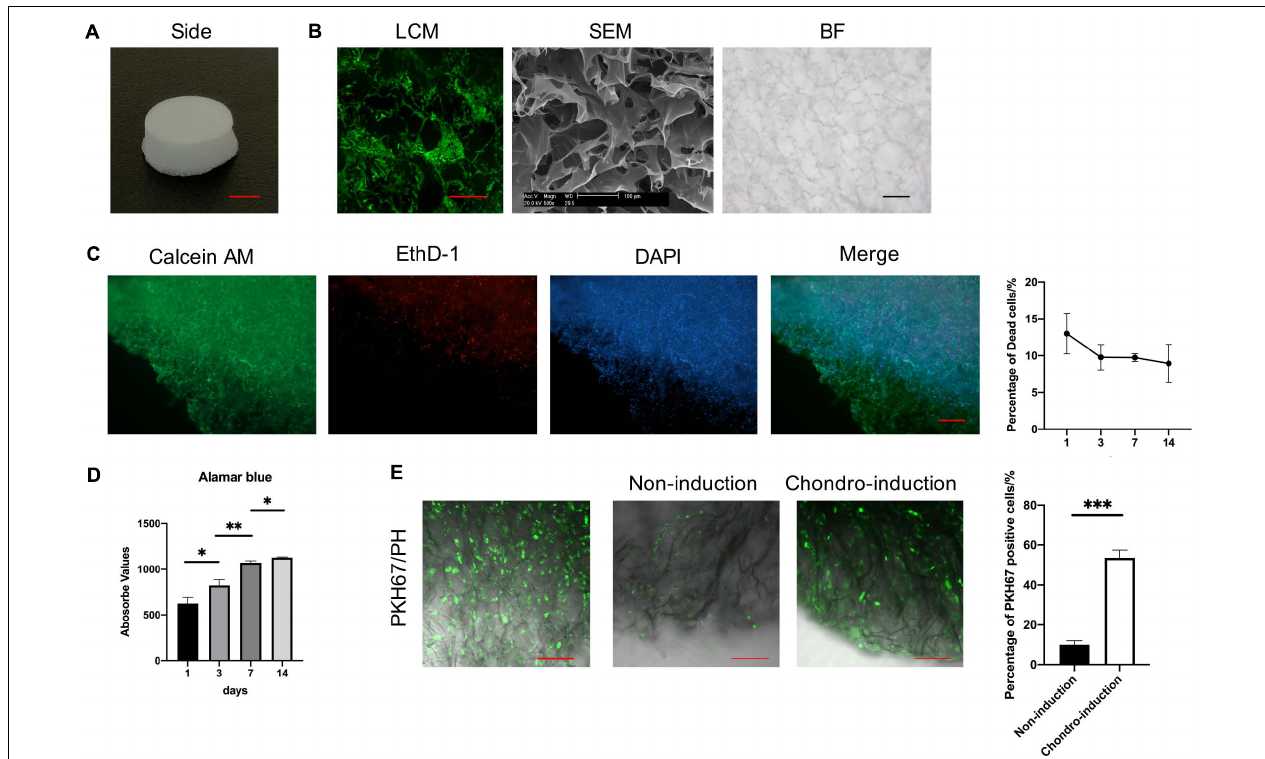
FIGURE 2 | The characterisation of CII-sponges. (A) The appearance of CII-sponges, scale bar 0.5 cm. (B) The pore structure of CII-sponges scanned by laser confocal (LCM), scanning electricity (SEM), and bright field (BF) Microscopes, scale bar 200 µ m (LCM), 100 µ m (SEM), and 200 µ m (BF). (C) The cell viability of TSPCs seeded in CII-sponges was detected by LIVE/DEAD assay, live cells (Green), dead cells (Red), and Nuclei (Blue), scale bar 200 µ m. The percentage of dead cells in total cells at day 1, 3, 7, and 14 were analysed by Image ProPlus. (D) AlamarBlue detected the proliferation of TSPCs cultured in CII-sponges. (E) In vitro tracking of TSPCs labelled with PKH67 in CII-sponges. Scale 100 µ m. The percentage of PKH67 positive cells with or without chondrogenic induction was qualified by Image ProPlus. * represented as p (cid:53) 0.05, ** represented as p (cid:53) 0.01, and *** represented as p (cid:53)